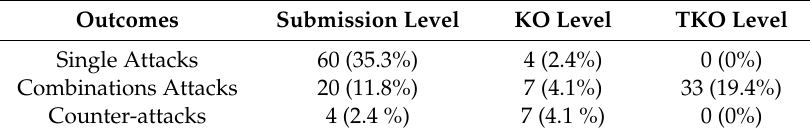
Table 3. Technical–tactical characterization in terms of their